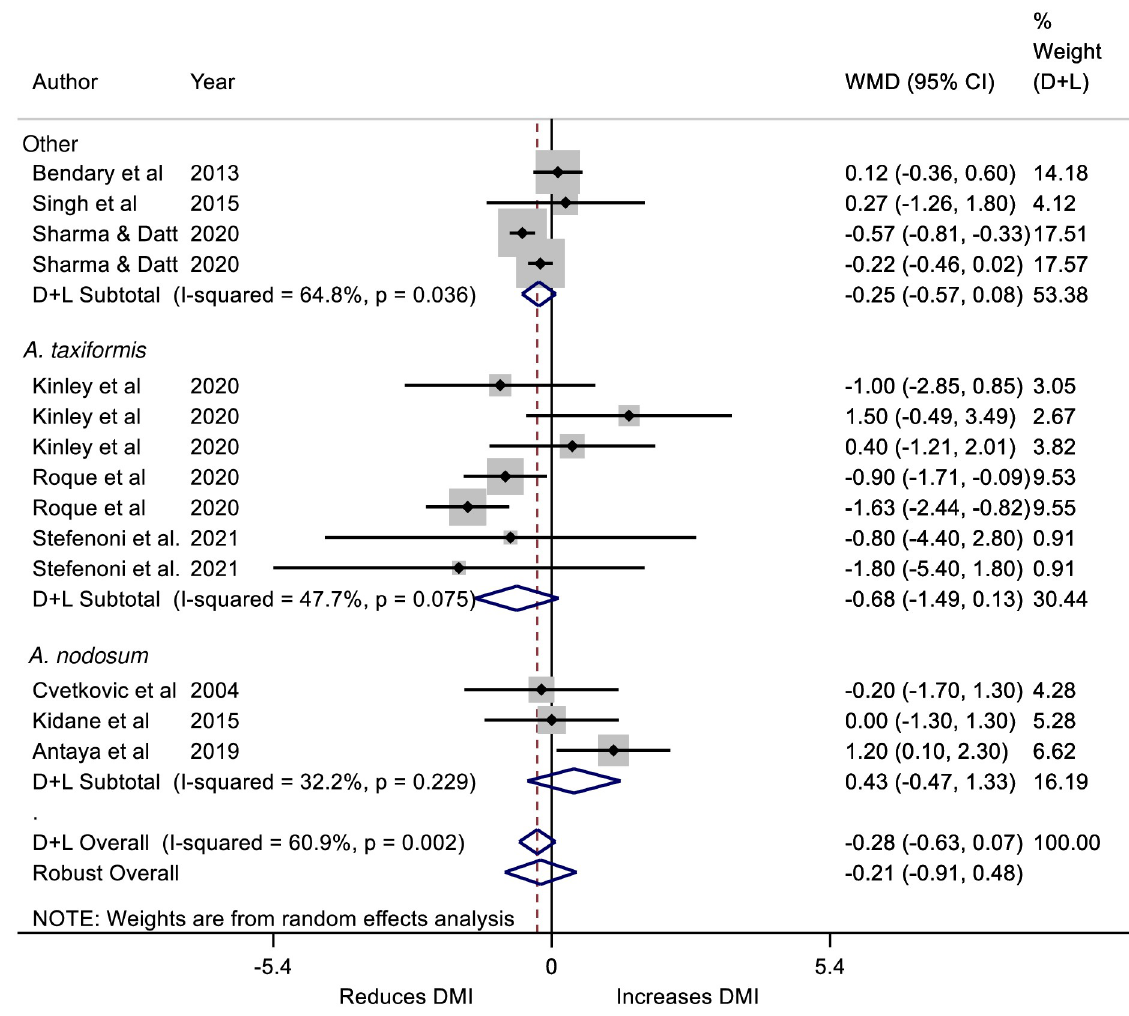
Fig 3. Forest plot of the Weighted Mean Difference (WMD) and 95% CI of the effect of seaweed intervention on the Dry Matter Intake (DMI; kg/d) of cattle. Effects for Ascophyllum nodosum and Asparagopsis taxiformis and ‘Other’ seaweed interventions are provided as well as an overall effect. The solid vertical line represents a mean difference of zero or no effect. Points to the left of the line represent a reduction in DMI, while points to the right of the line indicate an increase. Each square around the point effect represents the mean effect size for that comparison and reflects the relative weighting of the comparison to the overall WMD estimate. The larger the box, the greater the comparison contribution to the overall estimate. The weights that each comparison contributed are in the right-hand column. The upper and lower limit of the line connected to the square represents the upper and lower 95% CI for the WMD. The overall pooled WMD and 95% CI pooled using the DerSimonian and Laird (D+L) [23] and robust meta-analytical random effects models [18, 26] are indicated by the respective diamonds at the bottom. The heterogeneity measure, I 2 is a measure of residual variation among comparisons included in the meta-analysis. The DMI was substantially heterogeneous as indicated by the overall I 2 of